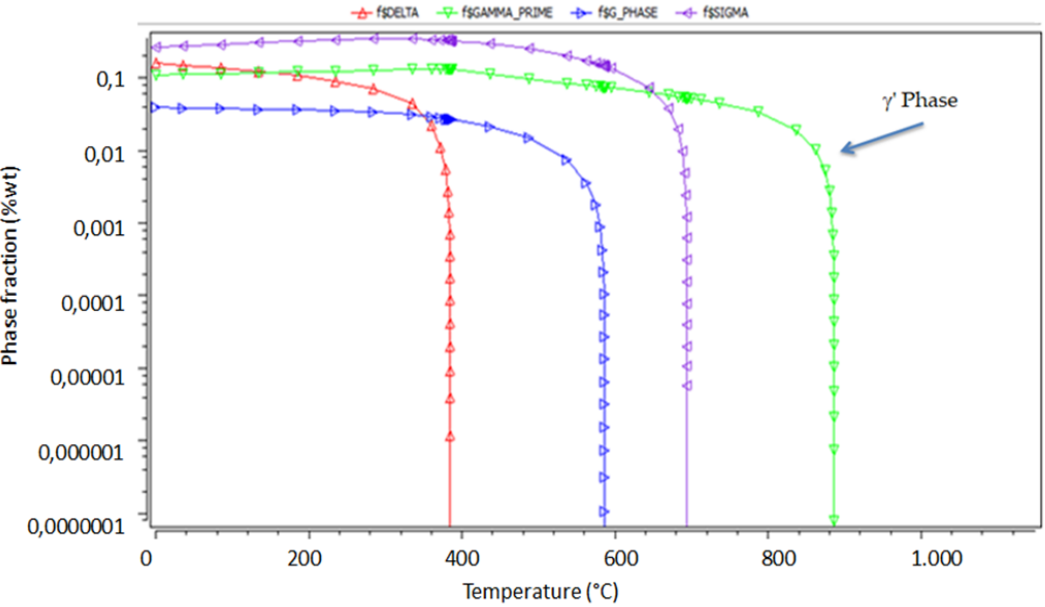
Figure 5. MatCalc ® simulation results for 800H steel. Precipitate equilibrium dissolution temperatures.